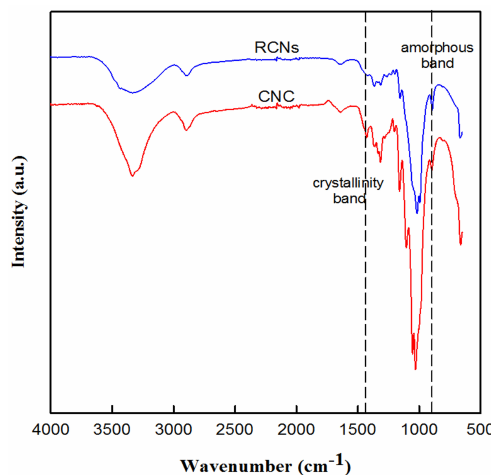
Figure 2. FT-IR spectroscopy bands of RCNs prepared by hydrolyzing MCC with a NaOH-based aqueous solution and CNCs by H 2 SO 4